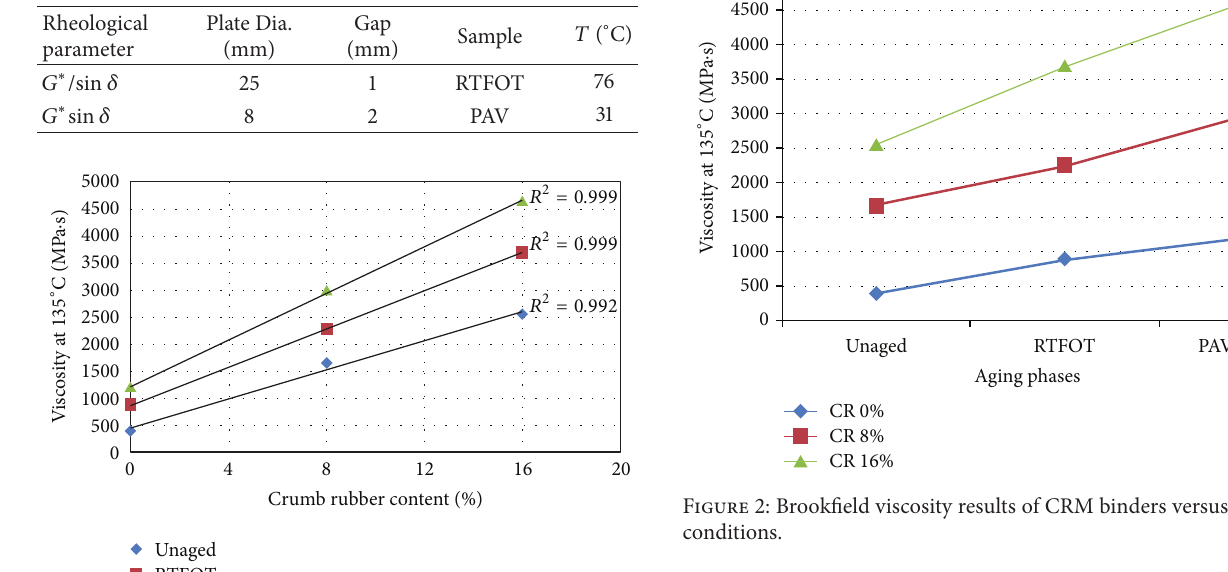
Table 4: DSR condition test used in the current study.